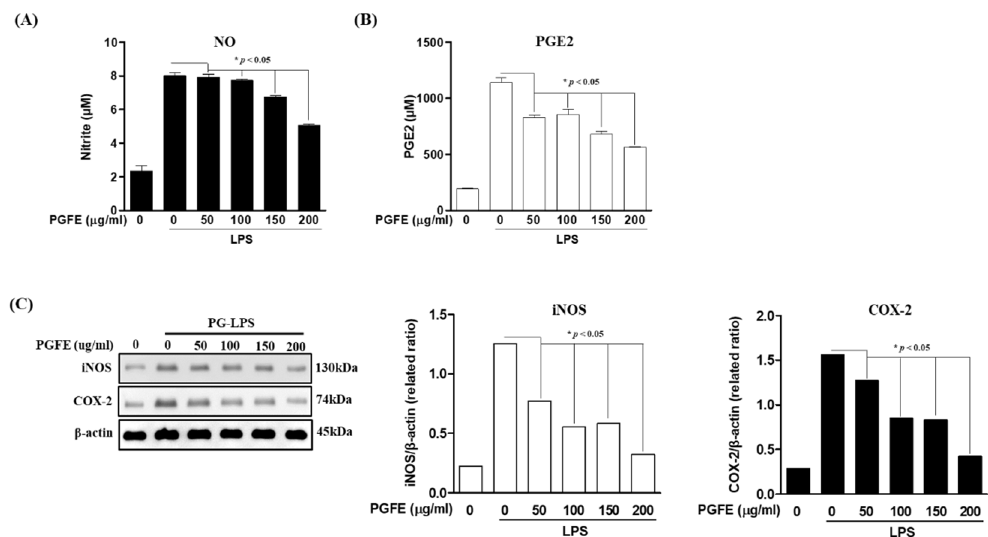
Figure 3. Inhibitory effects of PGFE on Porphyromonas gingivalis lipopolysaccharide (PG-LPS) induced pro-inflammatory mediators in HPDL cells. The HPDL cells were pretreated with the indicated concentrations (50–200 µg/mL) of PGFE for 6 h and then stimulated with or without PG-LPS for 24 h. The level of ( A ) NO and ( B ) PGE2 production was measured by an ELISA kit. ( C ) The expression of inducible nitric oxide synthase (iNOS) and cyclooxygenase-2 (COX-2) proteins were measured by Western blot analysis from cells pretreated with PGFE and stimulated by PG-LPS. * p < 0.05 was considered significant compared to only the PG-LPS treated group.